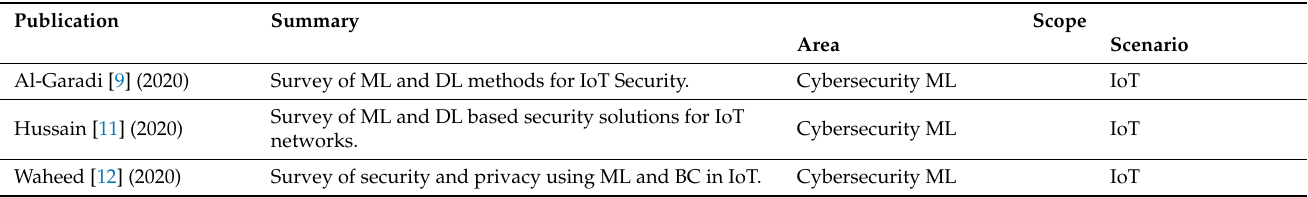
Table 1. Summary of existing surveys related to ML and DL for privacy